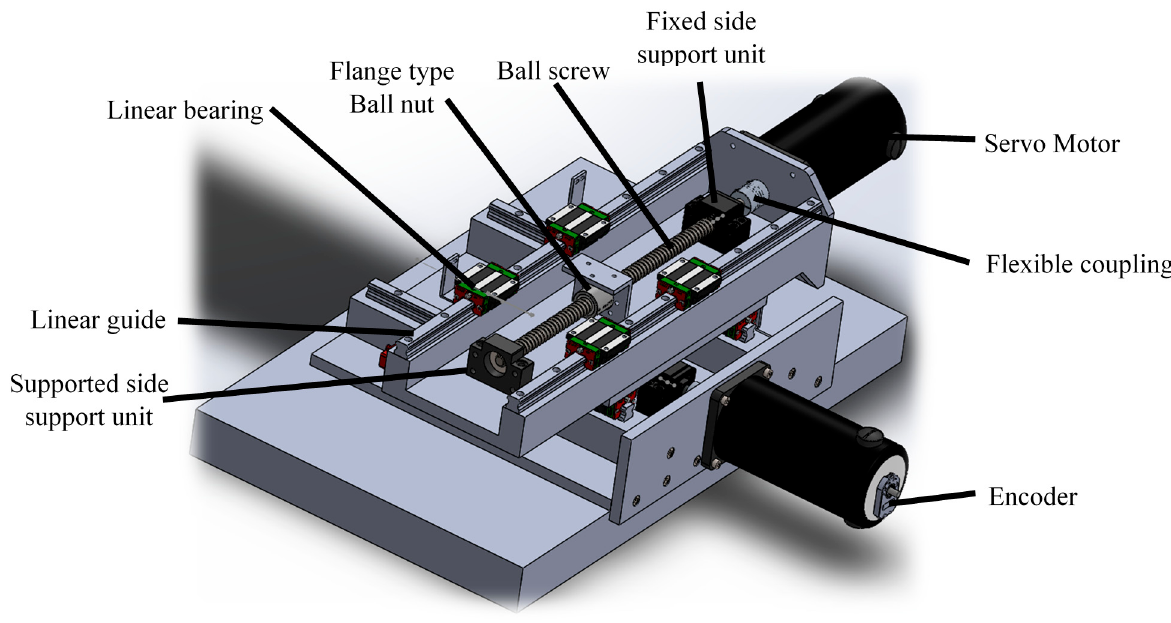
Figure 2. X and Y axes driving assembly.